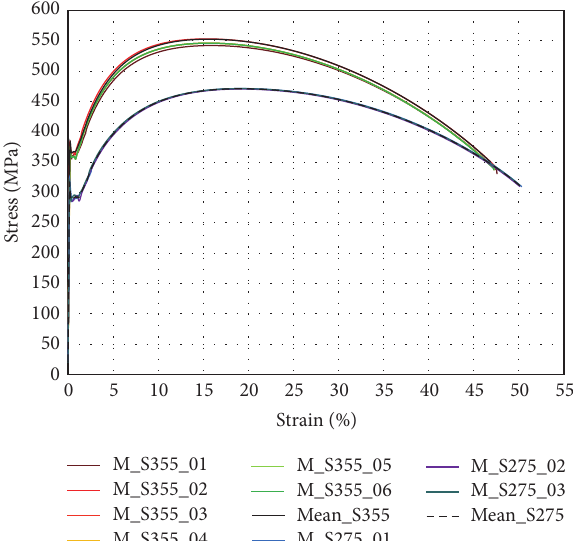
Figure 3: Stress-strain curves for monotonic loading.